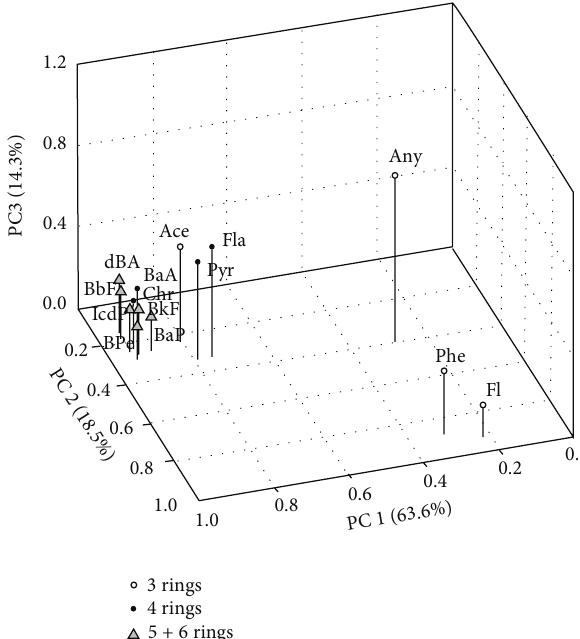
Figure 4: 3D loading plot of principal component analysis (PCA) for PAHs in surface sediments from the Yellow River-dominated margin. PC: principal